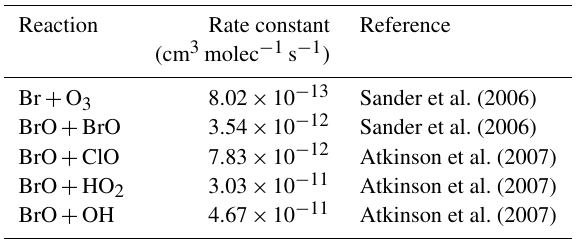
Table 4. Rates ( k ) of reactions provided in Sect. 1 and employed in Sect. 3.3. The temperature used for the calculations was T = 262K, similar to the mean temperature observed during 2015 at each sta- tion (Table